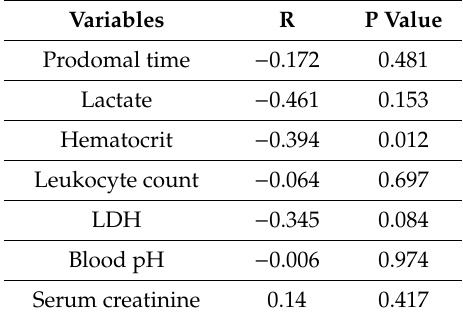
Table 3. Correlations between platelet count and other laboratory variables at hospital admission. We only found a significant correlation between platelet count and hematocrit level. LDH (lactate dehydrogenase).